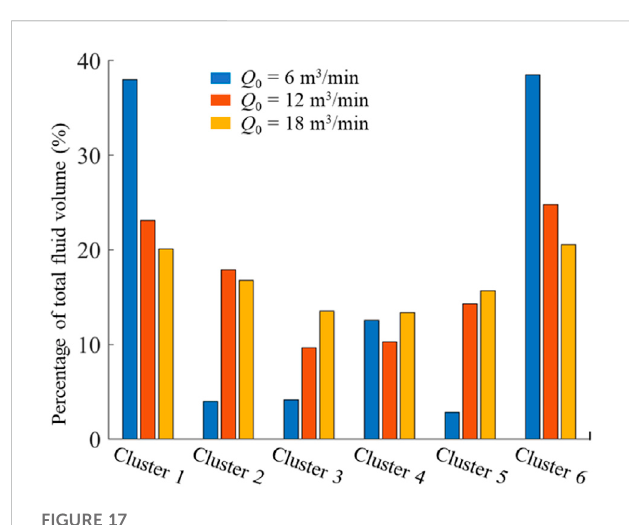
FIGURE 17 The total fl uid volume distribution of each cluster for three cases with different injection